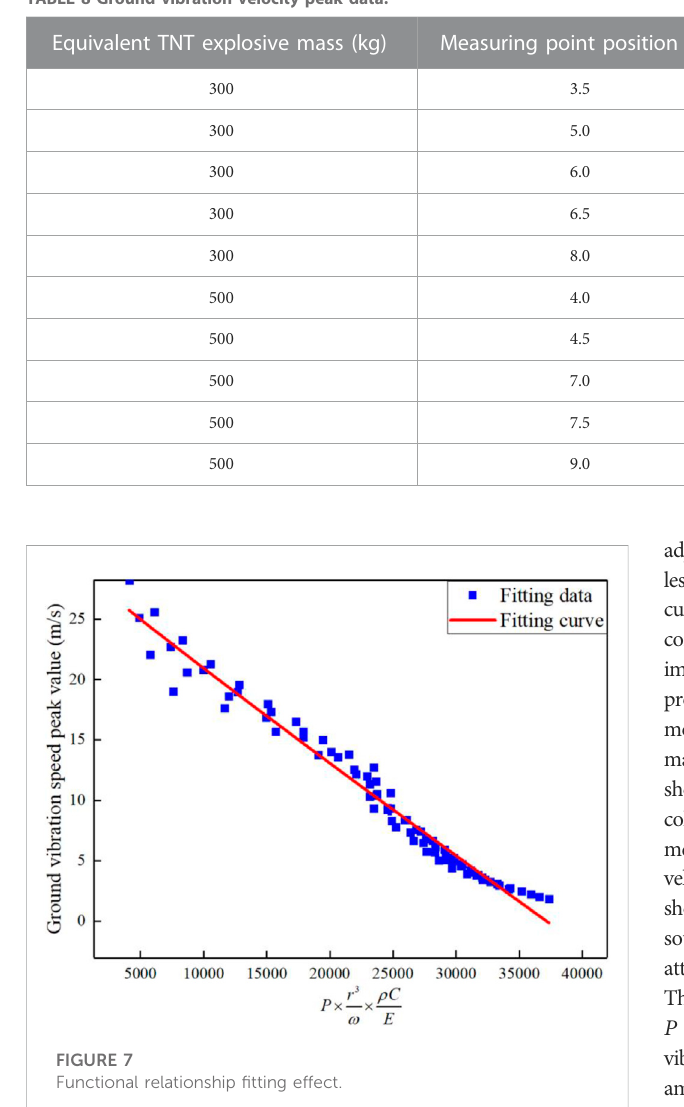
TABLE 8 Ground vibration velocity peak